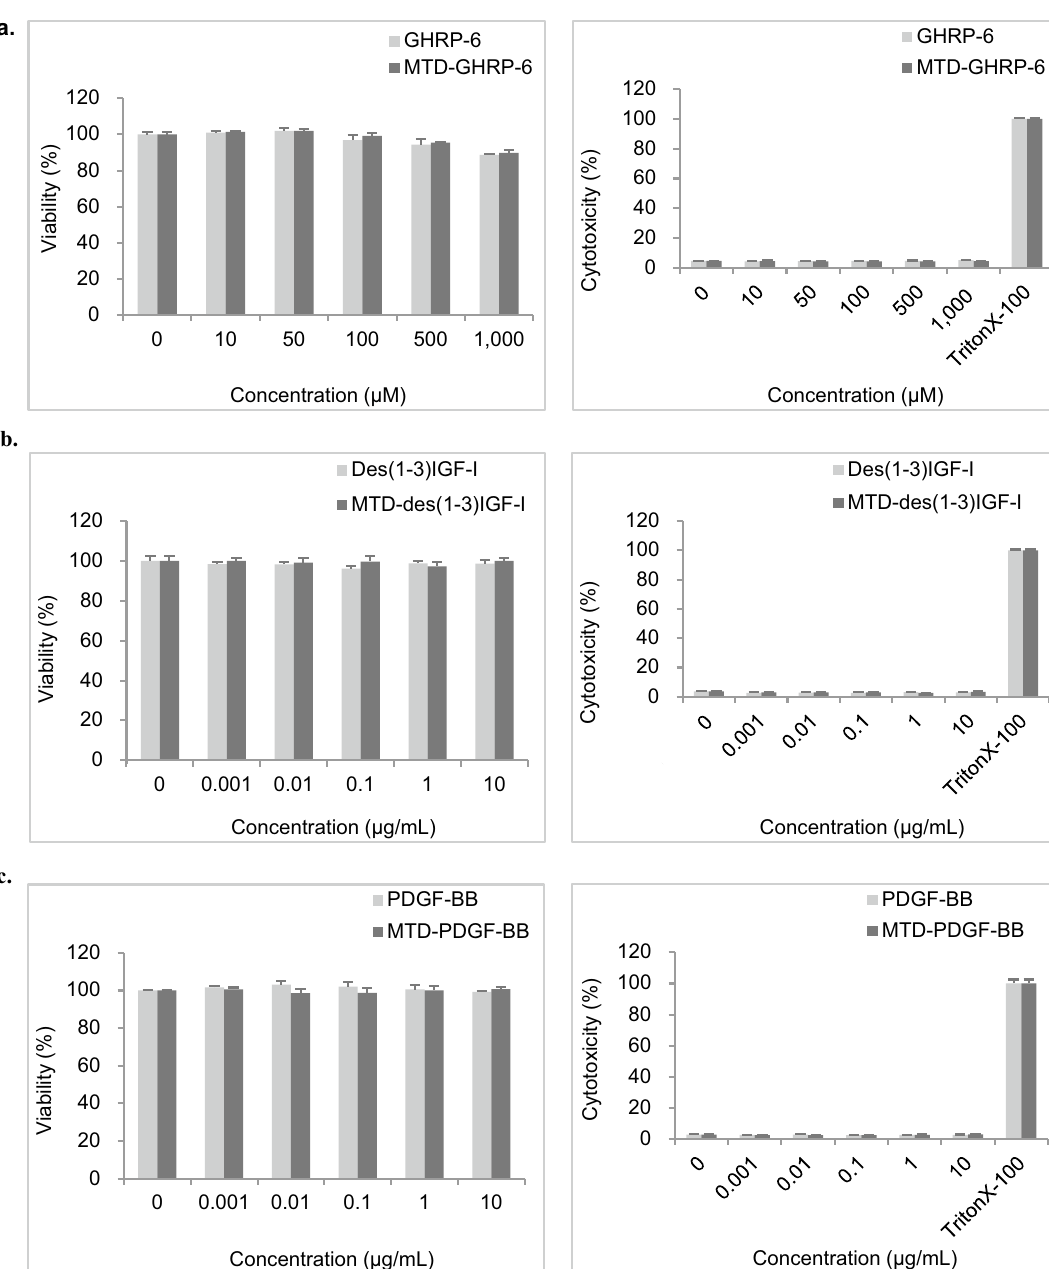
dermal fibroblast adult cells (HDFa) (Fig. 7). Taken together, our results strongly support the high potential of the hydrophobic peptide MTD 1067 as a promising vehicle for the transdermal delivery of functional protein cargoes of various sizes and structures in the development of advanced cosmetics and pharmaceuticals. The extended repertories of new CPPs, including MTD 1067, will help broaden the applicability of protein-peptide conjugates with the claimed bioactivity and safety as novel ingredients in cosmeceutical industry.